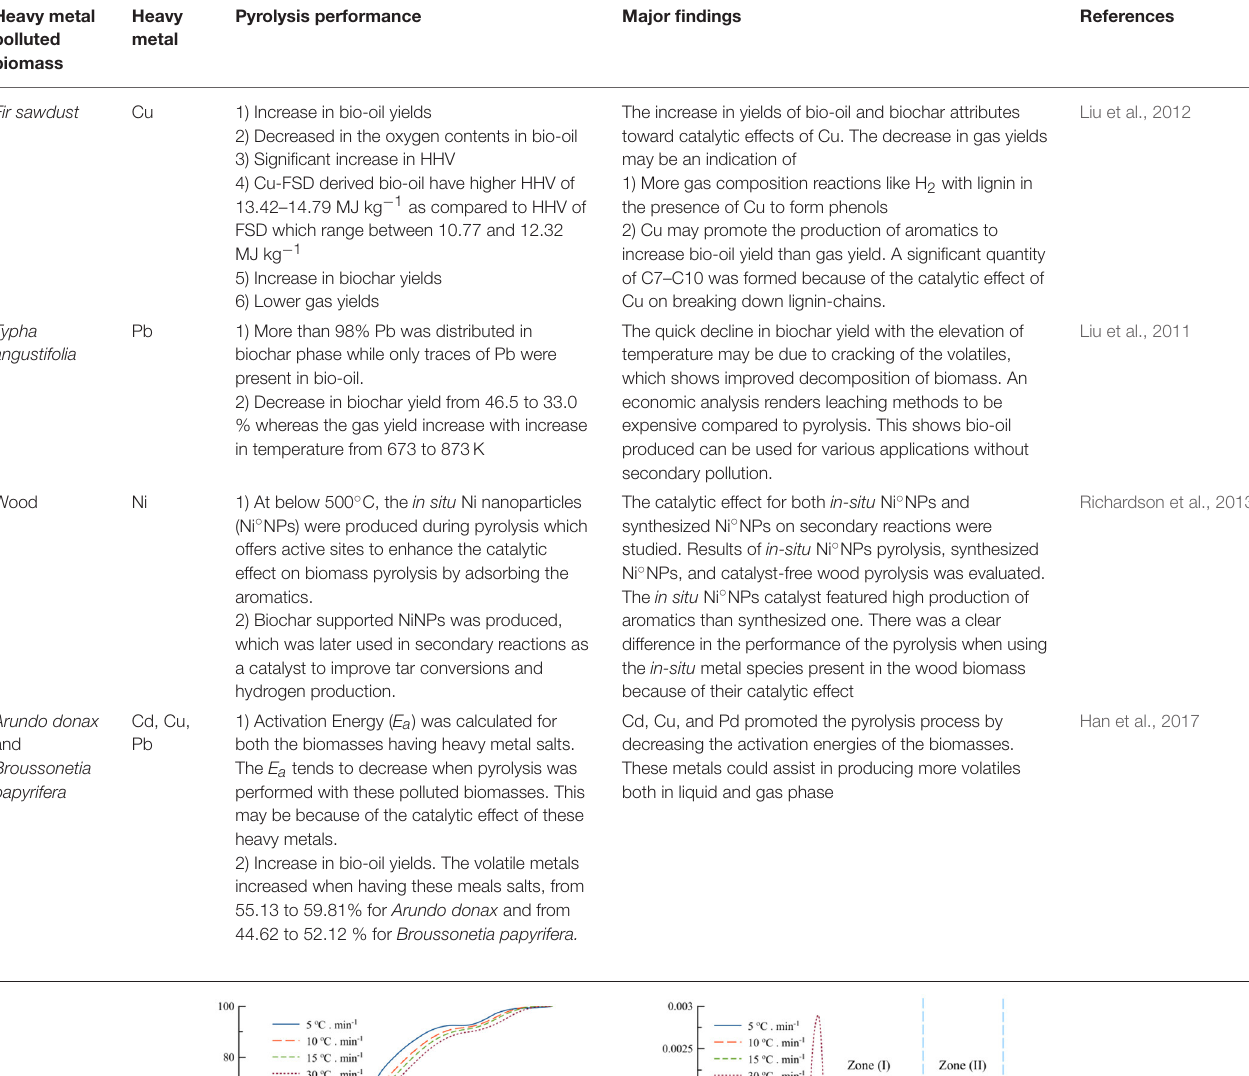
TABLE 4 | Influence of heavy metals present in biomass during pyrolysis.